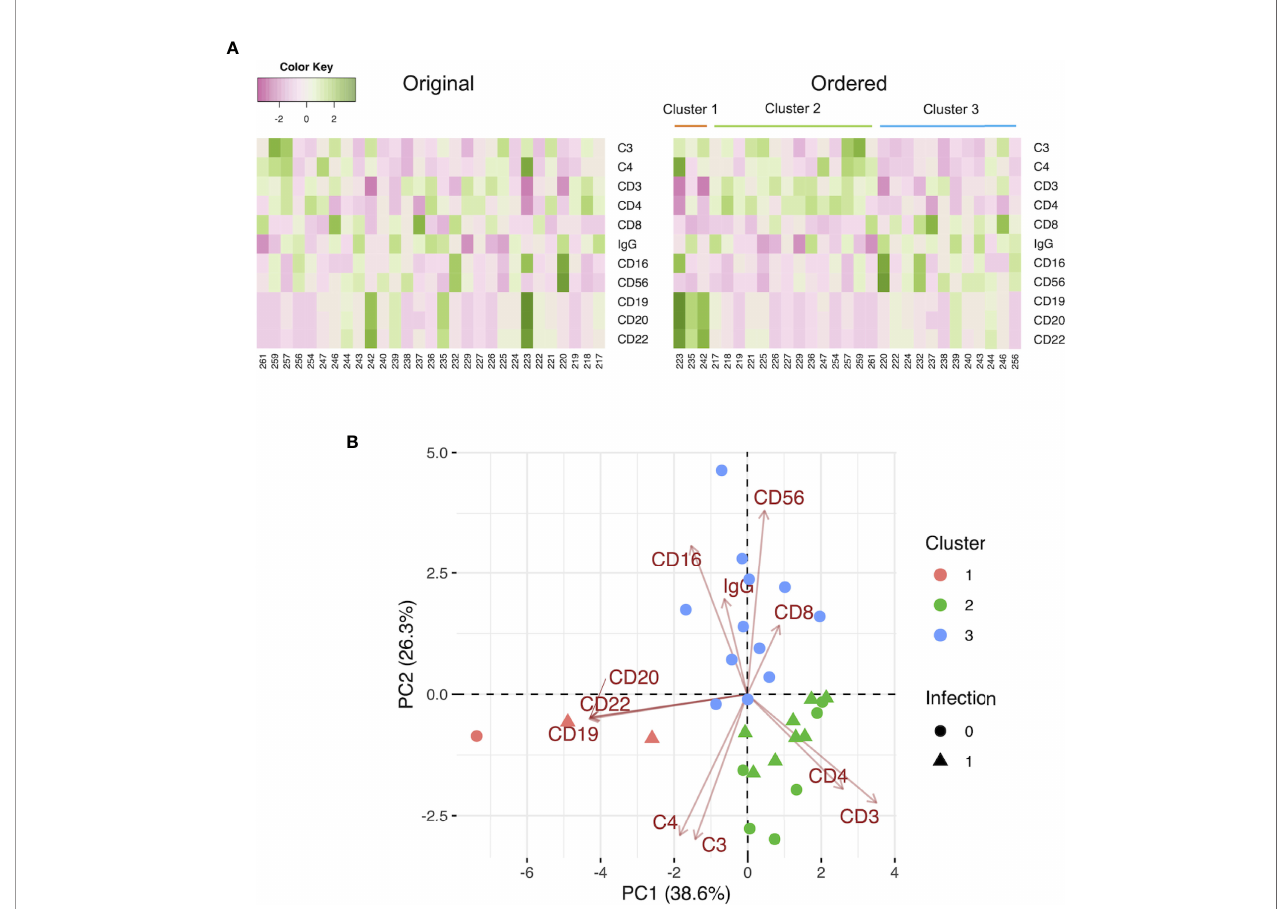
FIGURE 3 | (A) Heat maps of the preoperative C3, C4, and IgG levels, and the leukocyte populations with the original order (left panel) and the k-means clustering order (right panel). The numbers below the heat maps show the case number of each patient. (B) The two-dimensional principal component analysis using the preoperative C3, C4, and IgG levels, and the leukocyte populations. The colors indicate the cluster made by k-means clustering. Circles: patients without infection by day 7. Triangles: patients with infection treated with antibiotics by day